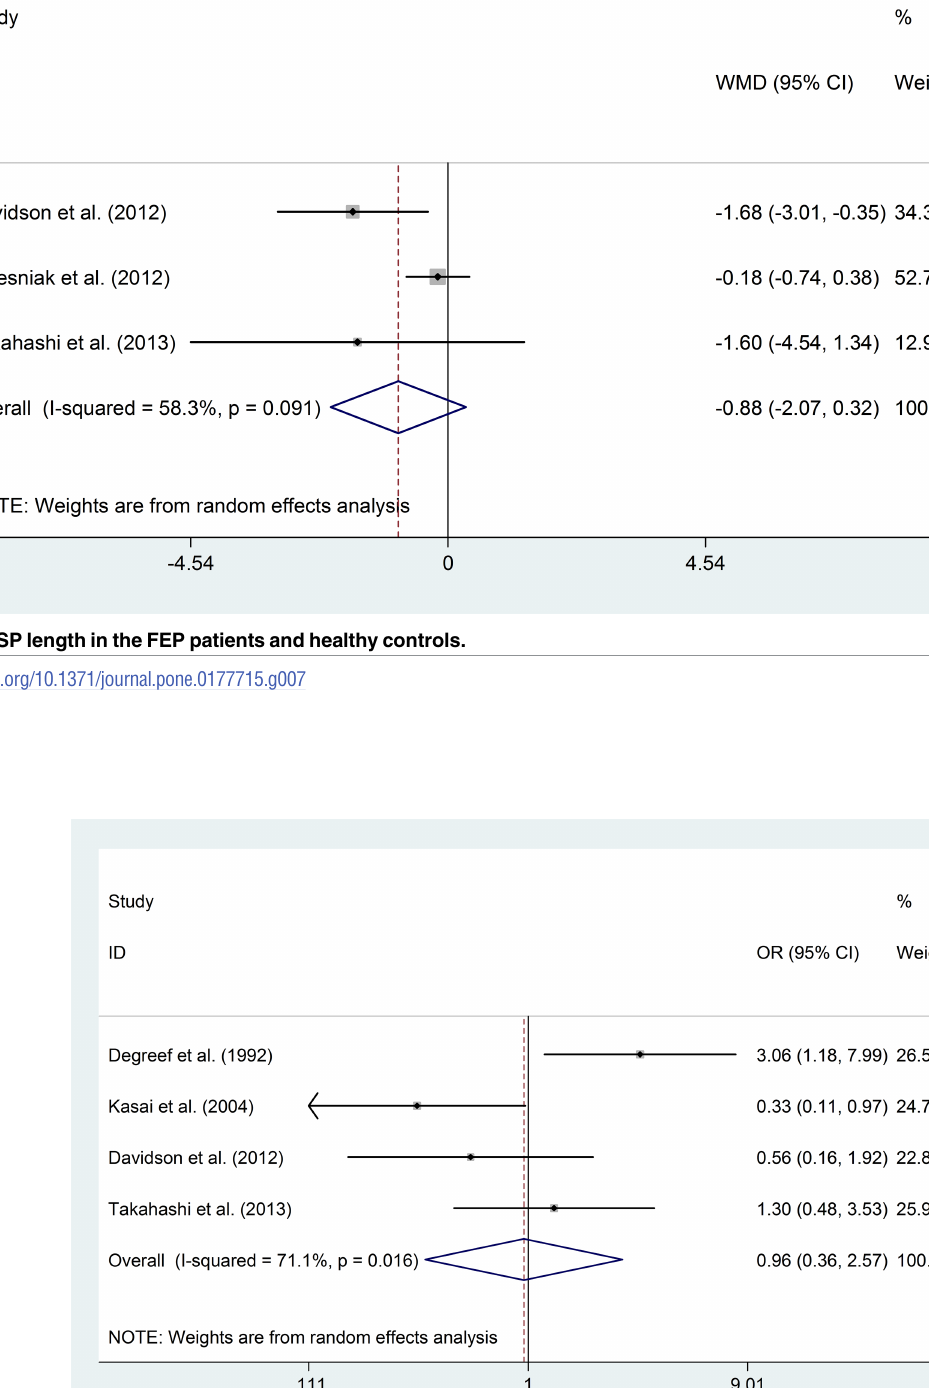
PLOS ONE | https://doi.org/10.1371/journal.pone.0177715 May 17,